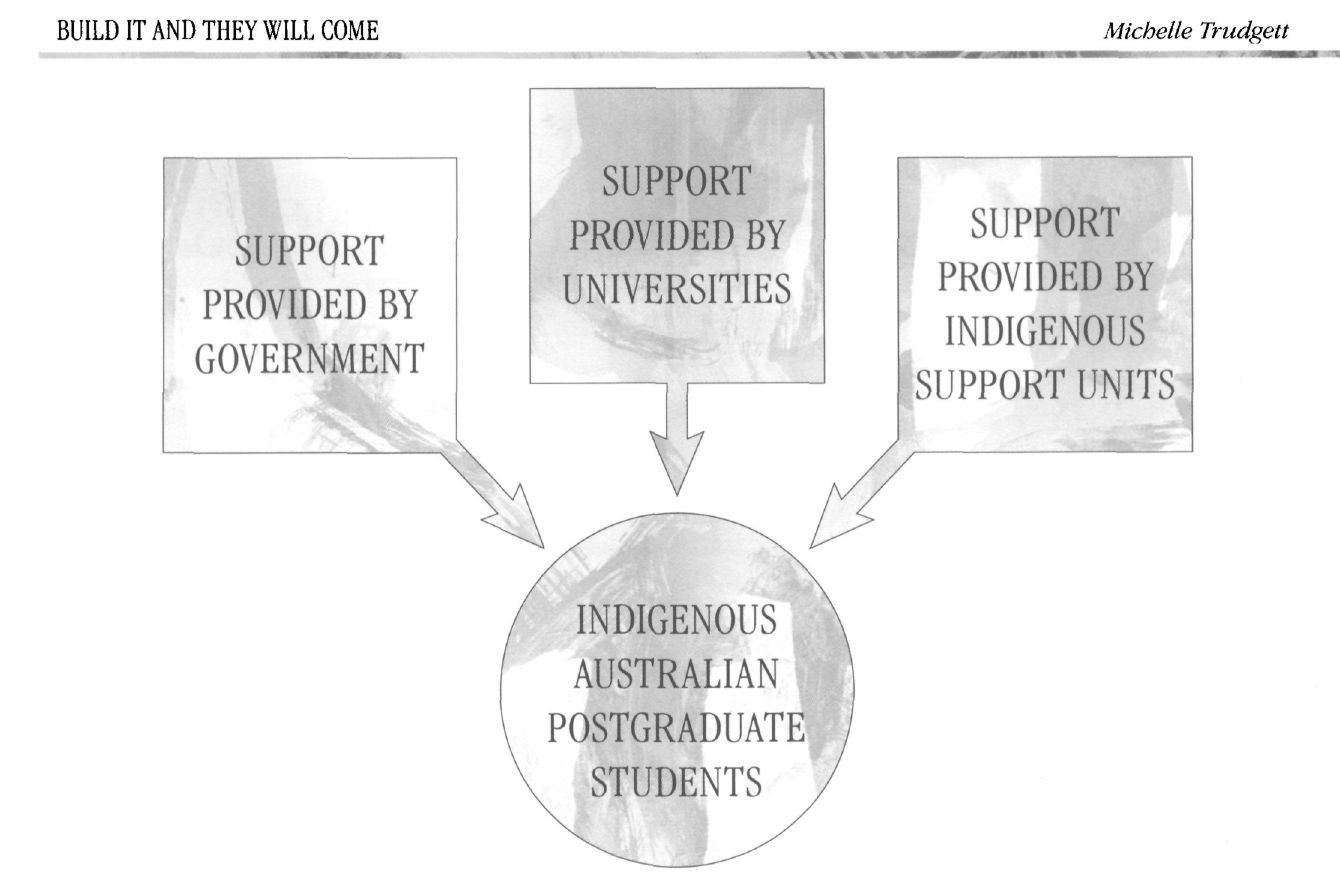
Figure 1: The three main areas responsible for supporting Indigenous postgraduate students. what has been termed "a relatively young population"